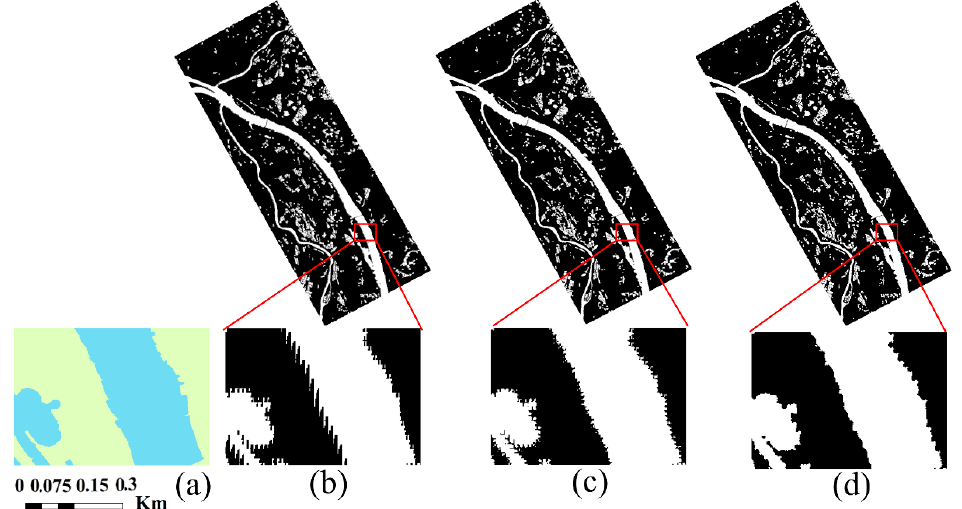
Figure 16. Subpixel water mapping results for Region D: ( a ) reference image; ( b ) SPM L ; ( c ) SPSAM; and ( d ) MSWM.